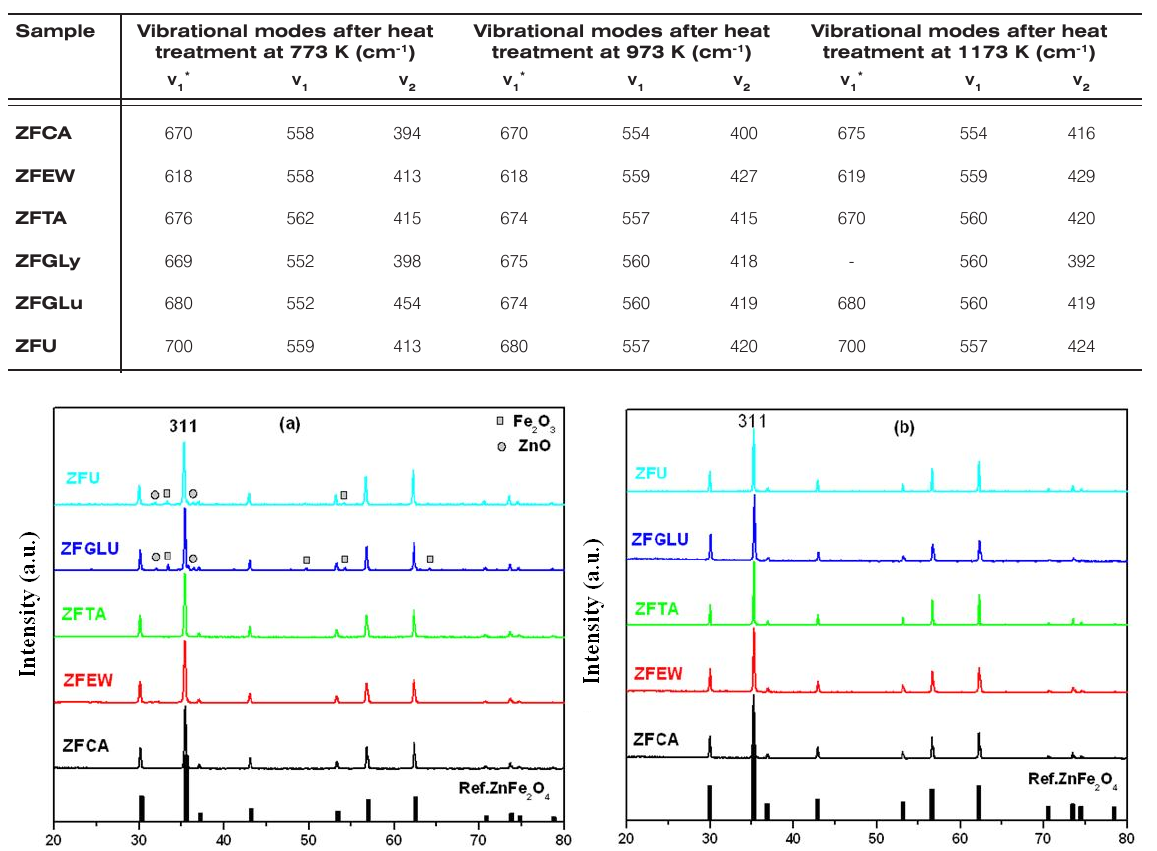
O , 82-1042, ICDD, JCPDS 2002), (b) after 2 4